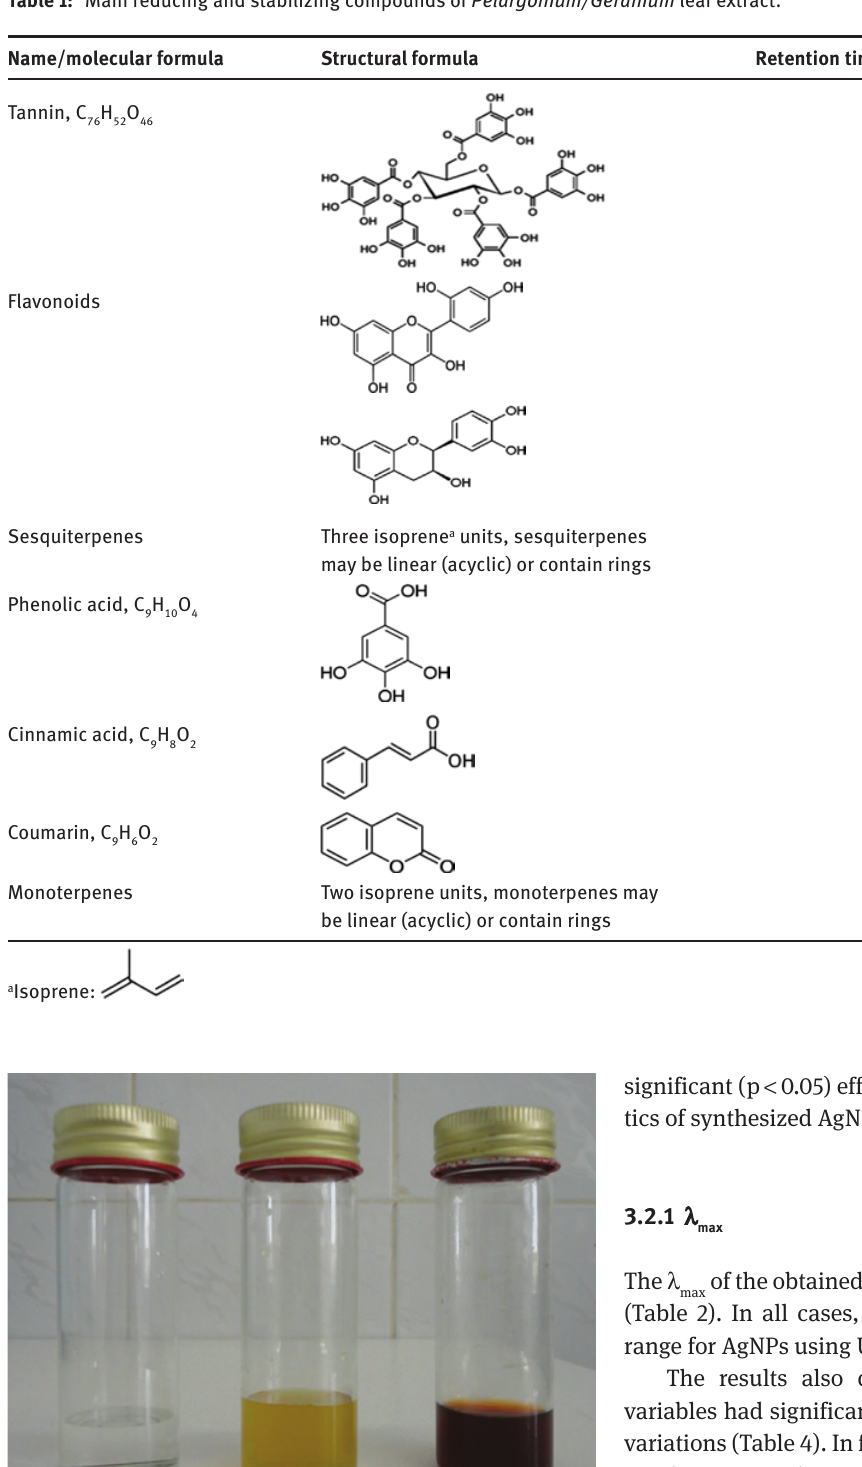
Table 1: Main reducing and stabilizing compounds of Pelargonium/Geranium leaf extract.